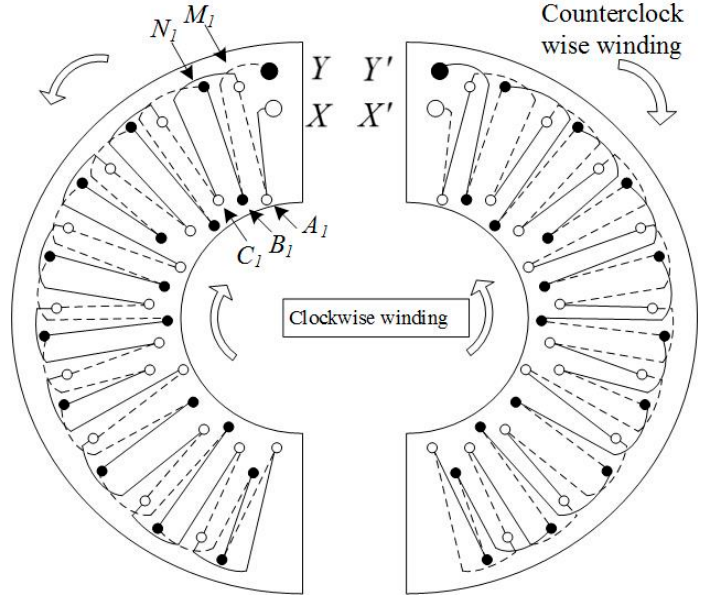
Figure 7. Connections of turns.